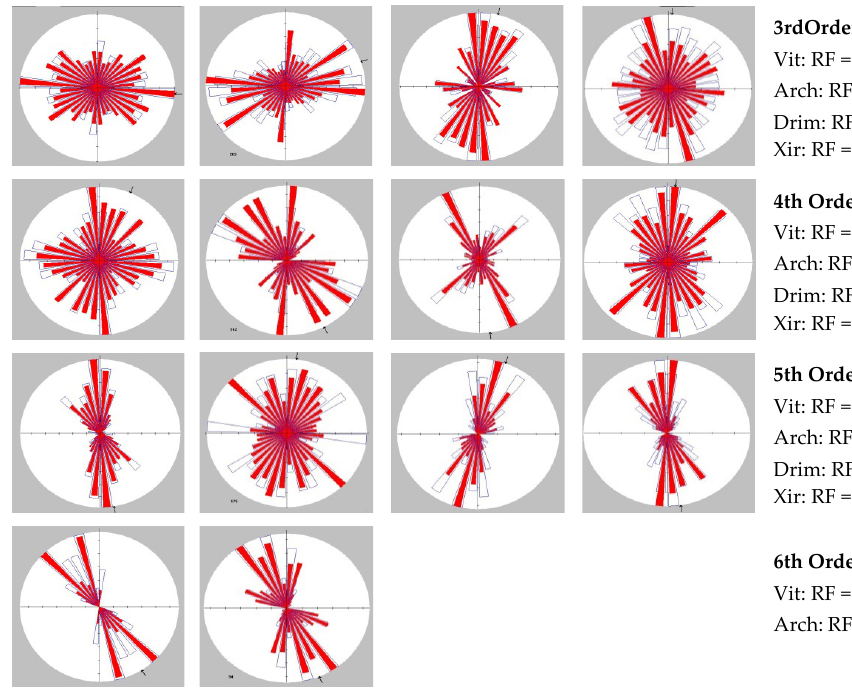
Figure 9. Rose diagrams of frequency (RF) and density (RD) of the eight sub-catchments’ drainage network with their mean angle range.